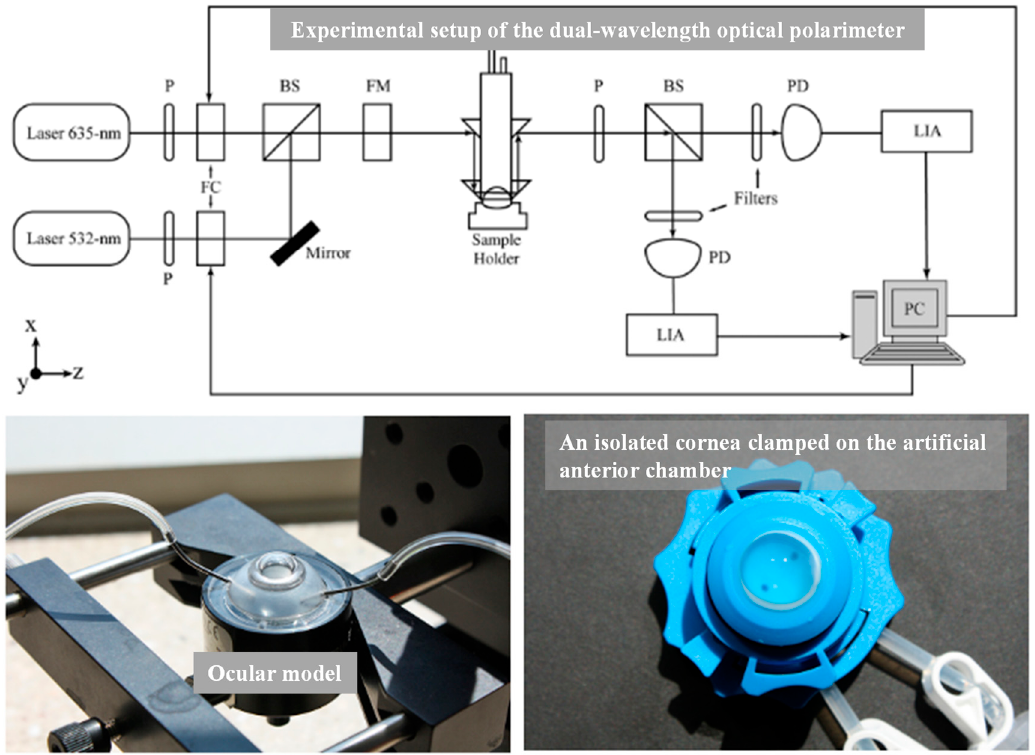
Figure 4. Optical polarimetry method: dual-wavelength polarimetric glucose sensing. Adapted with permission [67]. Copyright 2013, SPIE.